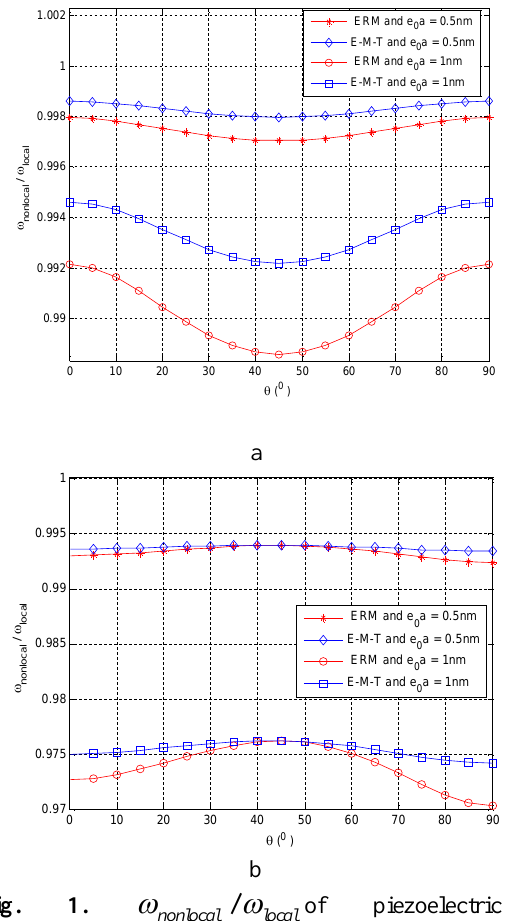
increase in SWCNT orientation angle up pi/4 for CPT and vice versa for FSDT. Also  decreases with increasing of the local e a ) for both plate nonlocal parameter ( 0 theories. This fact is due to increasing atomic distance. The results of E-M-R approach are closer to E-M-T approach for FSDT with respect to CPT.